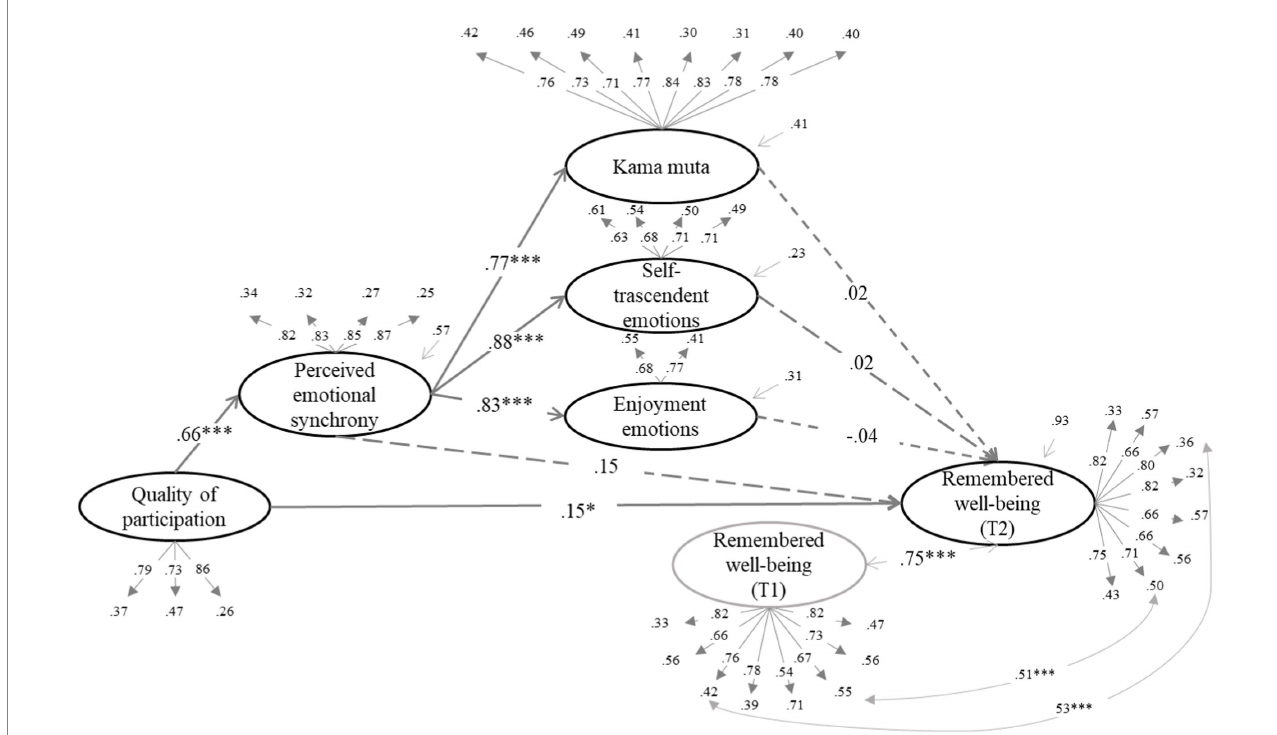
FIGURE 5 Perceived emotional synchrony and emotions as mediators of the effect of quality of participation on remembered well-being controlling for pre- participation scores. Model fit: χ 2 = (404, 616) = 1419.787, p < 0.001, CFI = 0.914, TLI = 0.907, RMSEA = 0.057, SRMR =